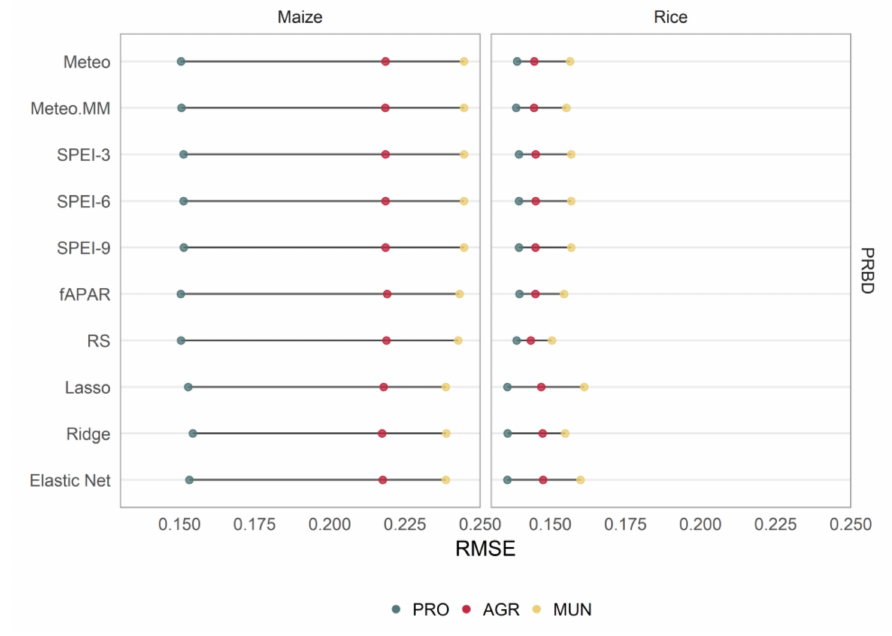
Figure 4. Analogous to Figure 3, but for summer crops (maize and